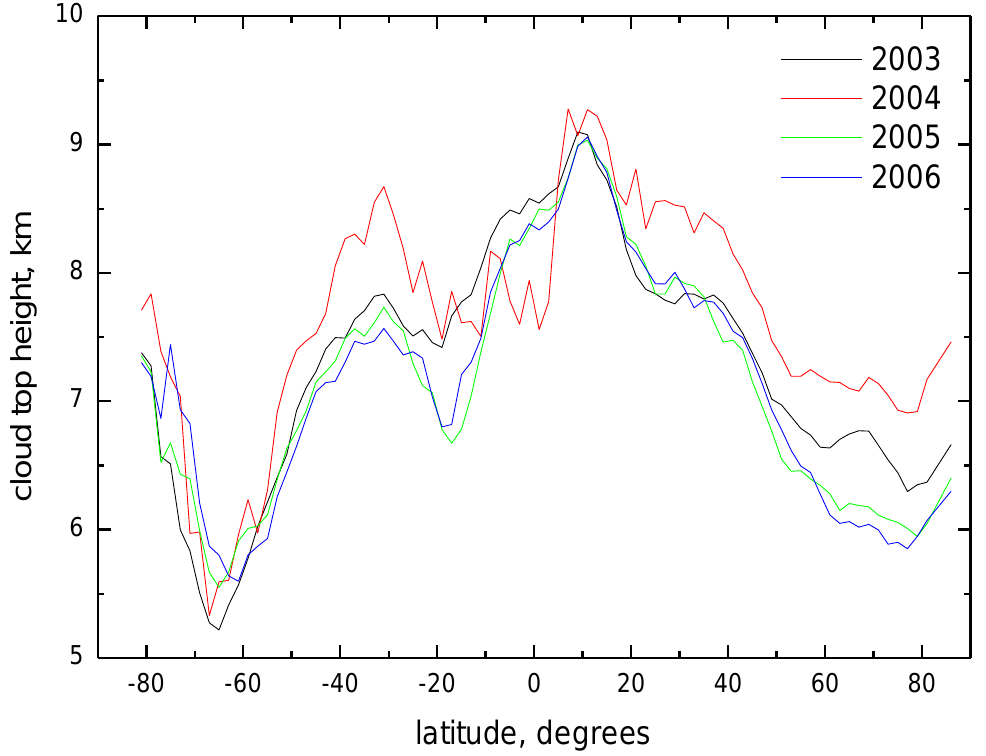
Figure 3. The latitudinal behavior of cloud top height (CTH) for